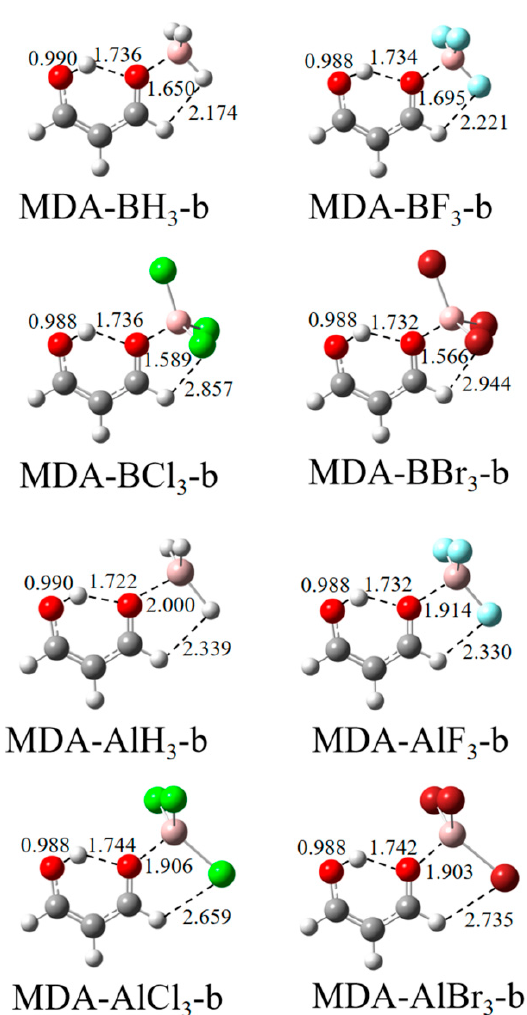
Figure 3. Structures of coplanar complexes of MDA formed by the carbonyl O with TrX 3 . Distances are in